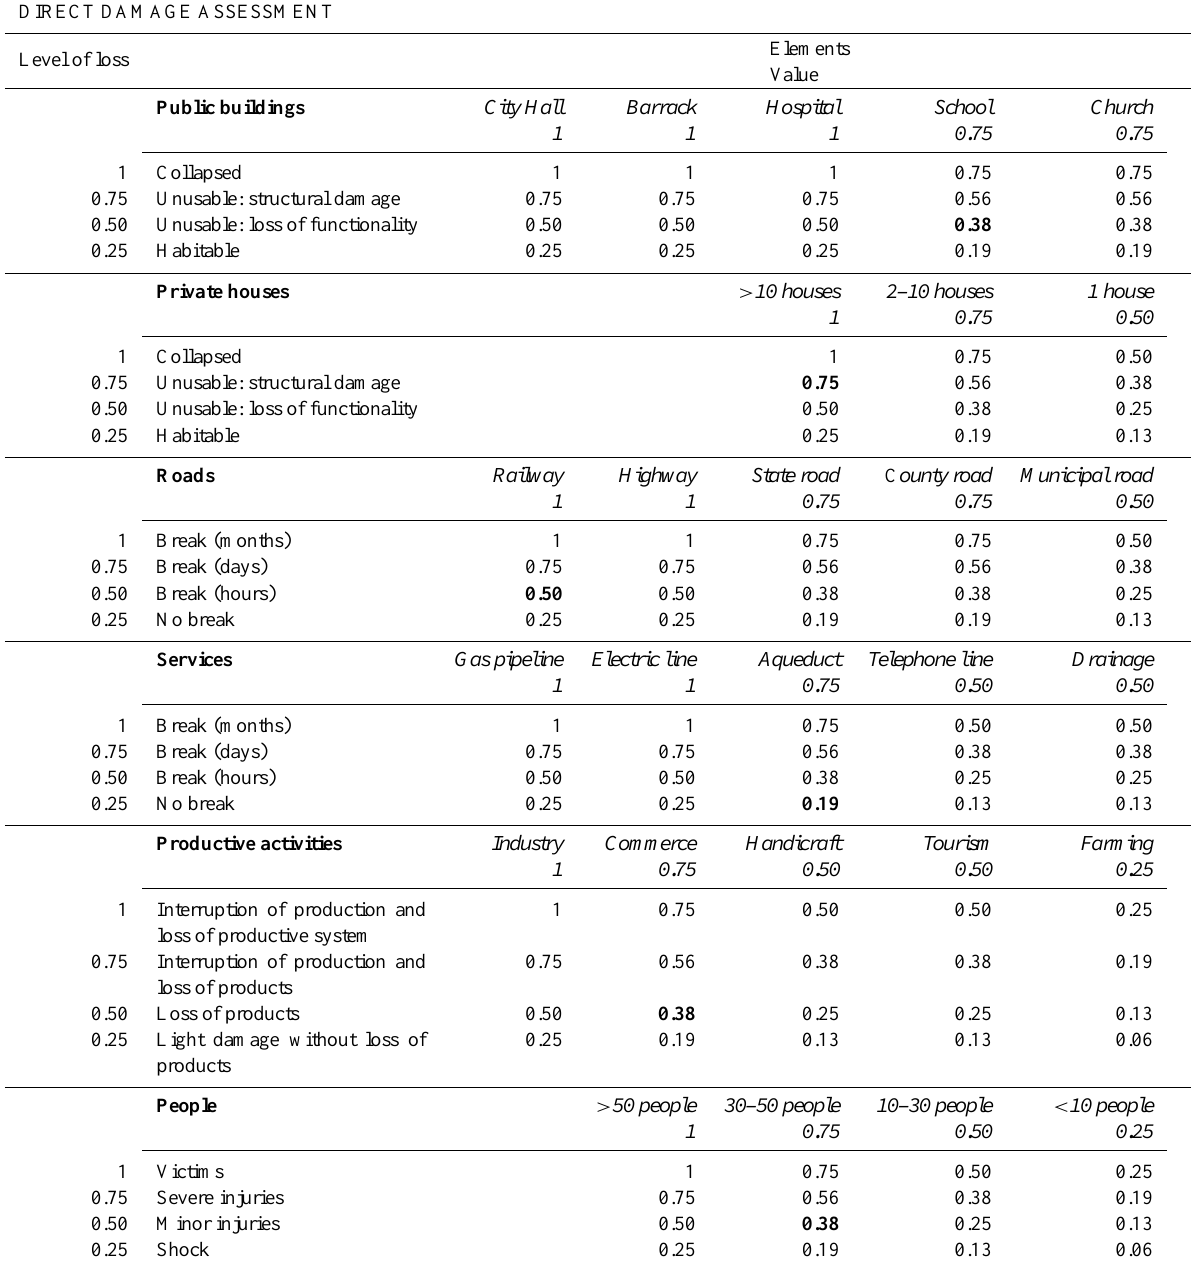
Table 1. Form to fill out to assess direct damage at municipal scale. The D Mun index is the sum of all the products Levels of loss × element value . In other words, if the damage indicated by bold text occurred, then D Mun =